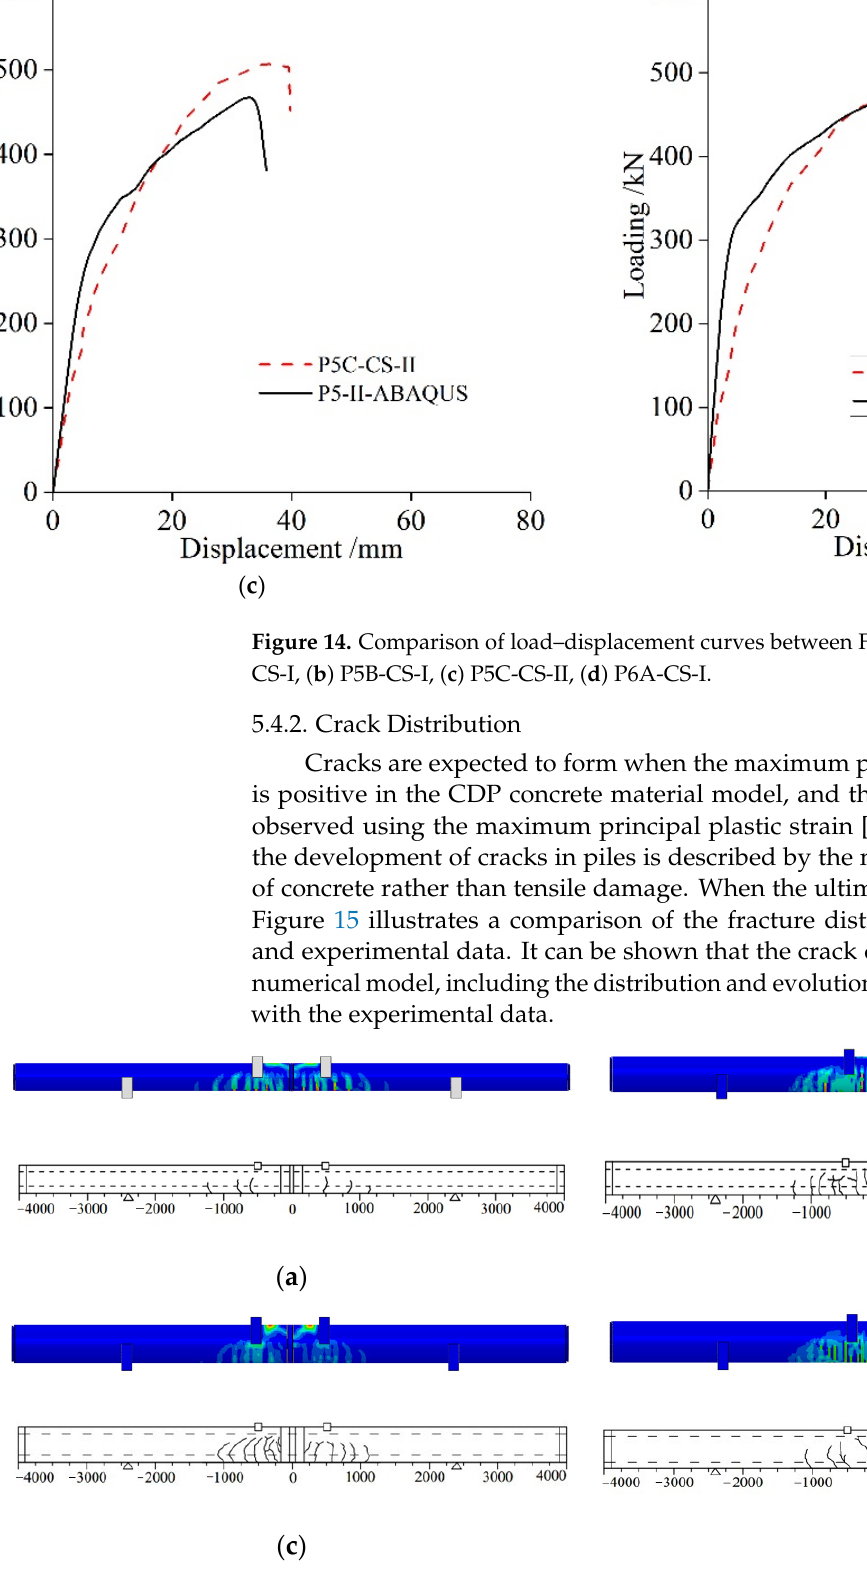
Figure 15. Crack distribution of numerical and experimental results for specimens: ( a ) P4-CS-I, ( b ) P5-CS-I, ( c ) P5-CS-II, ( d ) P6-CS-I.